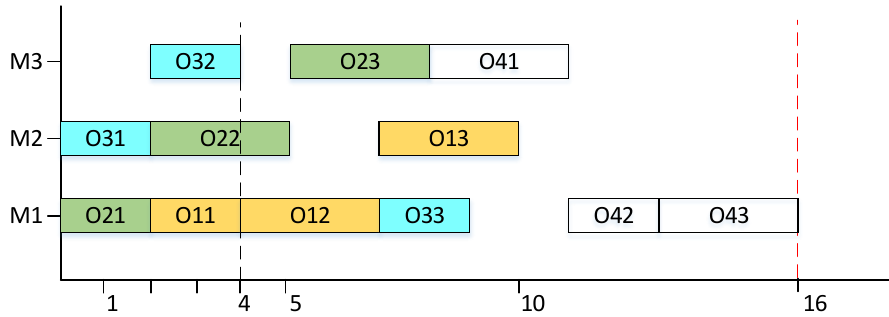
Figure 3. The scheduling scheme of method I with new job 4 insertion.